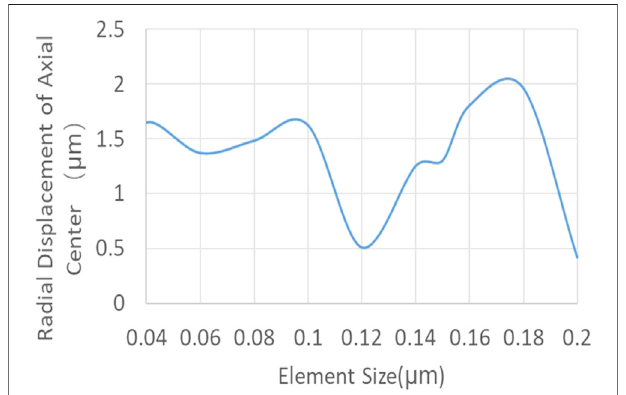
FIGURE 5 | Grid test of rotor system.